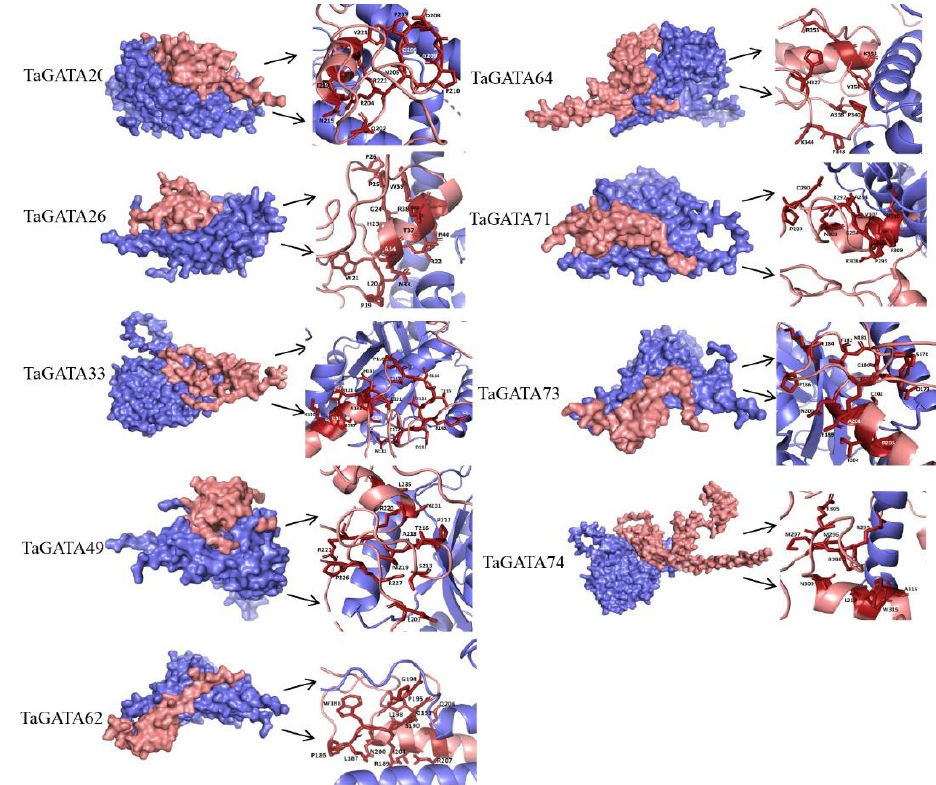
Figure 10. The docking modes of TaCOP9-5A with respect to nine TaGATA proteins, including TaGATA33, TaGATA62, and TaGATA73 from clade Ⅰ ; TaGATA26, TaGATA49, and TaGATA74 from clade Ⅱ ; TaGATA64 and TaGATA71 from clade Ⅲ; and TaGATA20 from clade Ⅳ . The docking modes of TaCOP-5A with TaGATA proteins and the binding sites between TaCOP9-5A and TaGATA proteins that overlapped with the distribution of motif 1 and motif 4 were presented. The original three-dimensional structures were predicted with Alphafold2.